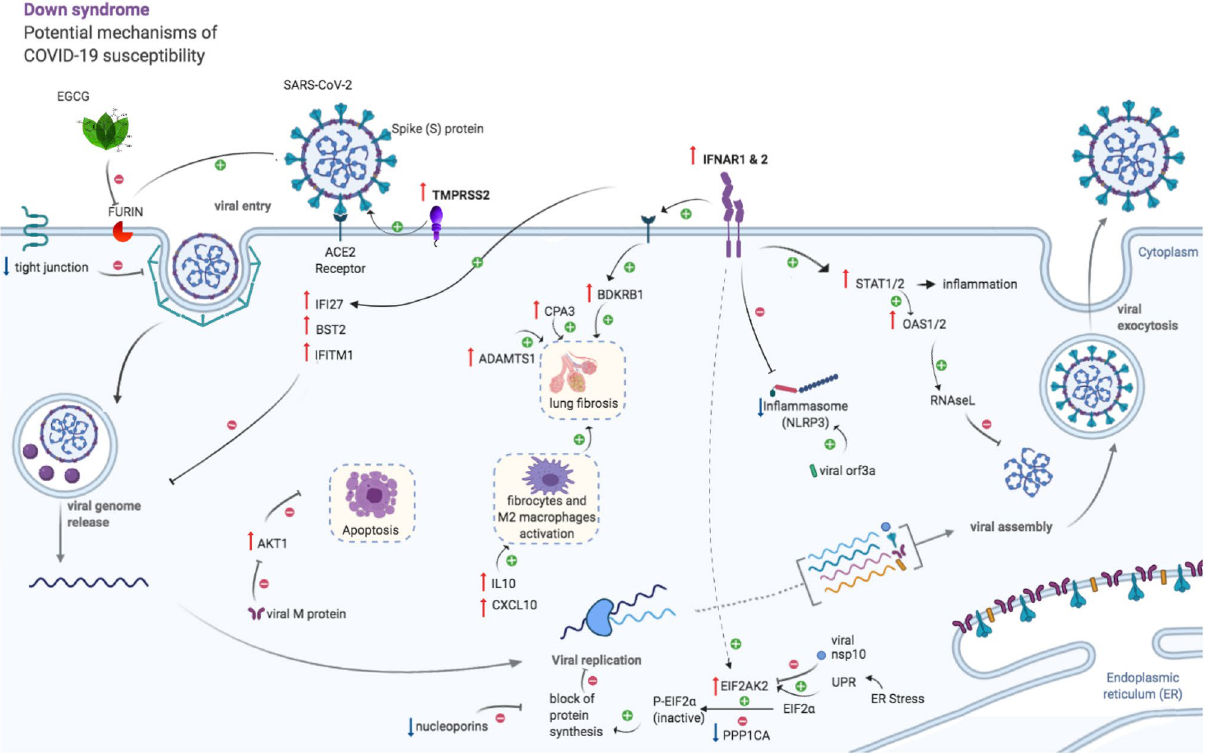
Figure 4. Summary of the molecular processes during COVID-19 infections that are affected in DS. The figure recapitulates the pathways affected in DS, and how they contribute to Sars-Cov-2 infection and the severity of COVID-19. Mechanisms contributing to viral entry: viral entry could be facilitated in DS thanks to TMPRSS2 triplication that leads to increased activation of the viral S-protein and also thanks to tight junctions’ downregulation, since tight junctions hamper virus’ endocytosis. Another protease able to prime the S-protein is FURIN, which can be inhibited by EGCG, a polyphenol that has been used in DS individuals. Mechanisms involved in inflammation and viral replication: triplication of IFNAR1/2 results in activation of the interferon (IFN) I response and subsequently of the JAK/STAT/OAS pathway, that in turn, leads both to increased inflammation but also to activation of the RNAseL that could degrade the viral RNA. We detected upregulation in DS of the interferon-induced antiviral proteins IFI27, BST2, IFITM1 , that inhibit viral genome release. ER stress, the unfolded protein response, and the IFN signaling lead to upregulation of EIF2AK2 that phosphorylate/inactivated EIF2α leading to the block of protein synthesis. The virus inhibits EIF2AK2 to allow viral replication, while in DS upregulation of EIF2AK2 together with downregulation of the phosphatase PPP1CA might block protein synthesis. However, the downregulation of nucleoporins in DS might instead favor viral replication. The viral protein M inhibits AST1 leading to apoptosis which could be counteracted in DS by AKT1 upregulation. Mechanisms involved in the severity of COVID-19: the IFN signaling also leads to increased bradykinin signaling (via ACE2 upregulation), that together with higher levels of CPA3 and ADAMTS1 can lead to lung fibrosis. The IFN signaling eventually downregulates the NLRP3 inflammasome (that is normally activated by the viral orf3a) which is downregulated in DS, leading to higher susceptibility to secondary bacterial infections. Finally, the cytokine storm could be potentiated in DS as a result of increased levels of the chemokine CXCL10 and IL10 that leads to increased fibrocytes and M2 macrophages activation leading to lung fibrosis. Upper red arrows indicate that the given gene is upregulated, blue down arrow,